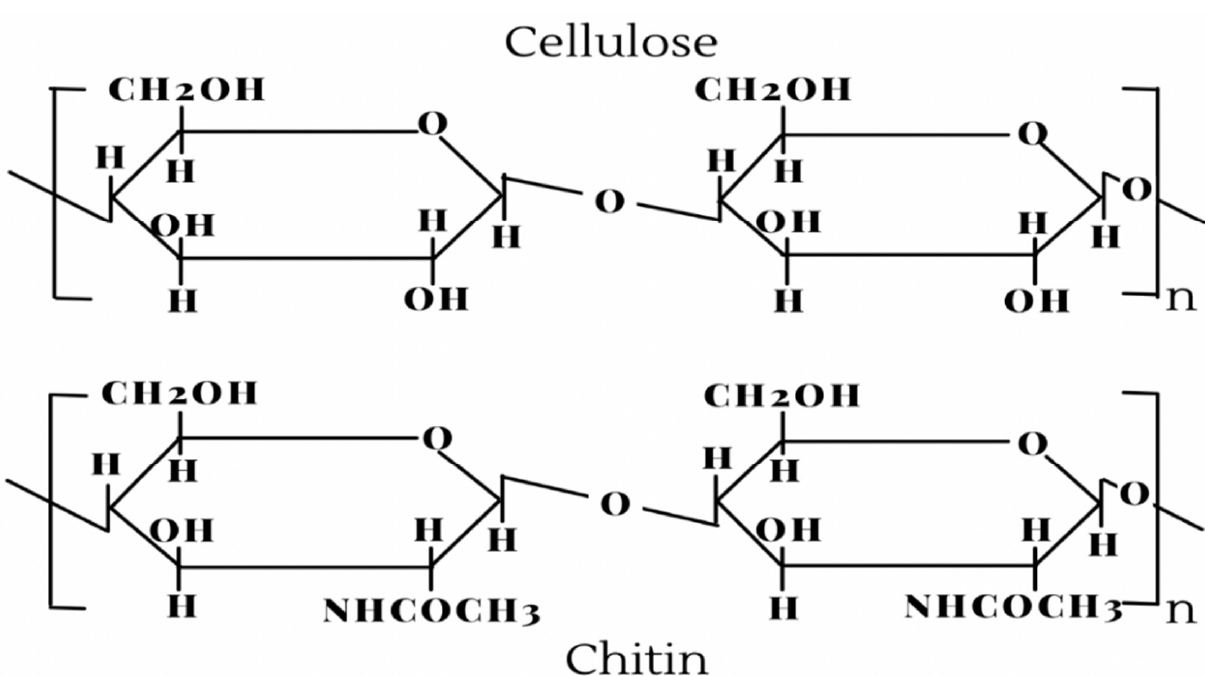
Figure 2. Molecular representations of chitin and cellulose.